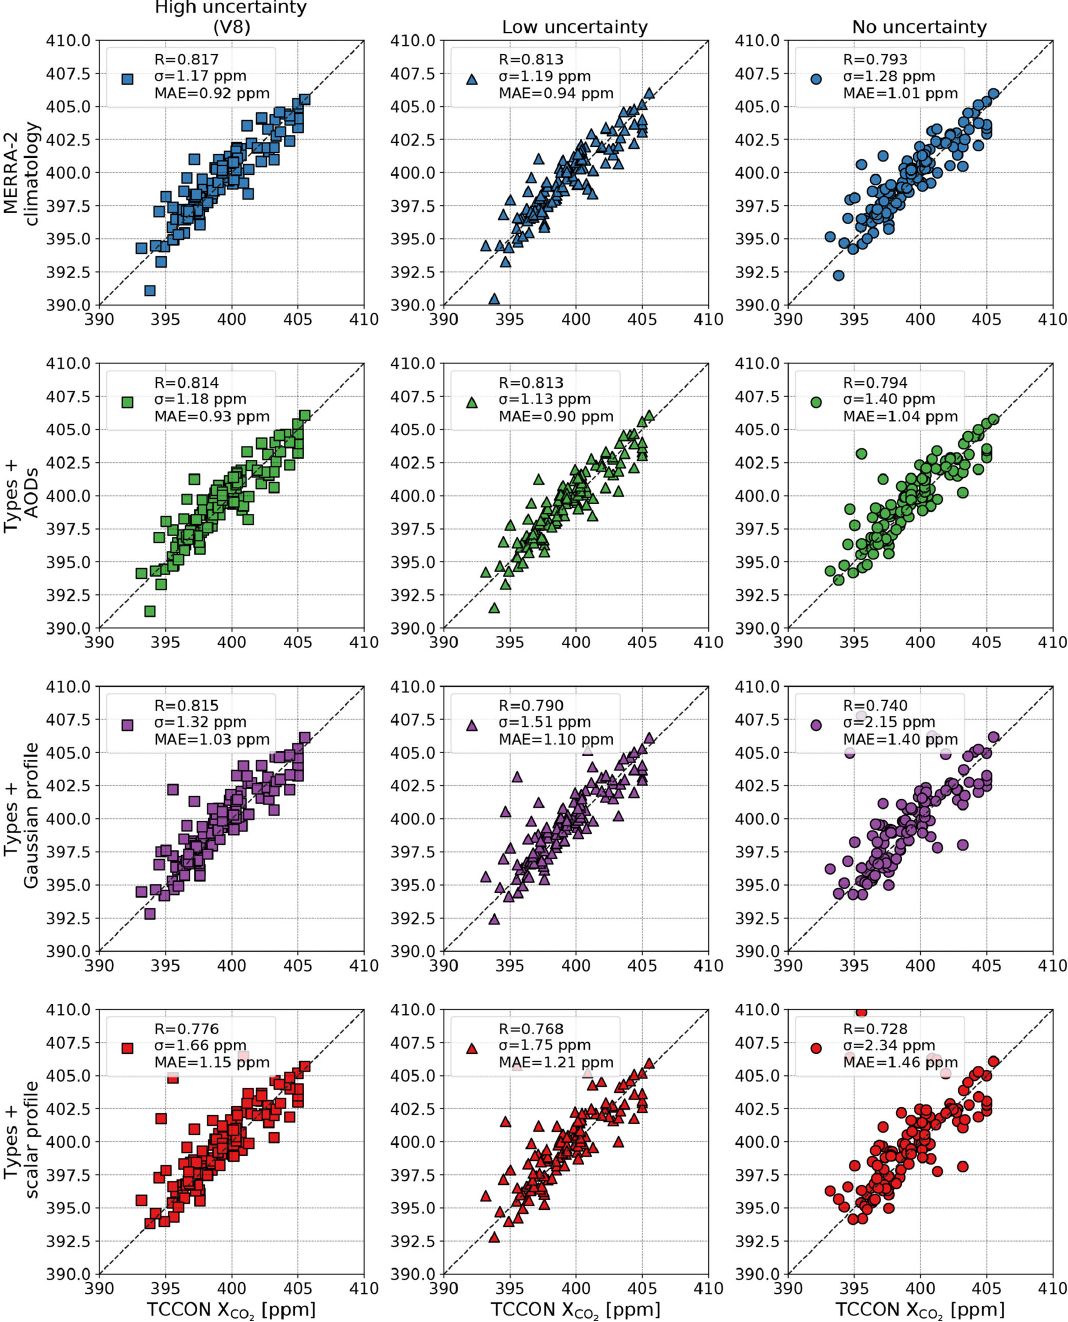
Figure 6. Retrieved OCO-2 X CO ( y axes) against TCCON X CO ( x axes). Overpass means are plotted. The first row is the operational 2 2 retrieval (V8). The second row is ingesting GEOS-5 types and AODs, the third row is ingesting GEOS-5 types and Gaussian profile priors, and the fourth row is ingesting GEOS-5 types and solving for a scalar to the prior aerosol profile. The left column is high uncertainty, the middle column is low uncertainty, and the right column is no uncertainty (see Table 2). For each panel, R is the correlation coefficient, σ is the standard deviation of the error against TCCON, and MAE is the mean absolute error against TCCON. The TCCON sites used are listed in Table 1, are shown in Fig. 2, and were required to have valid data between 17 September 2014 and 2 May